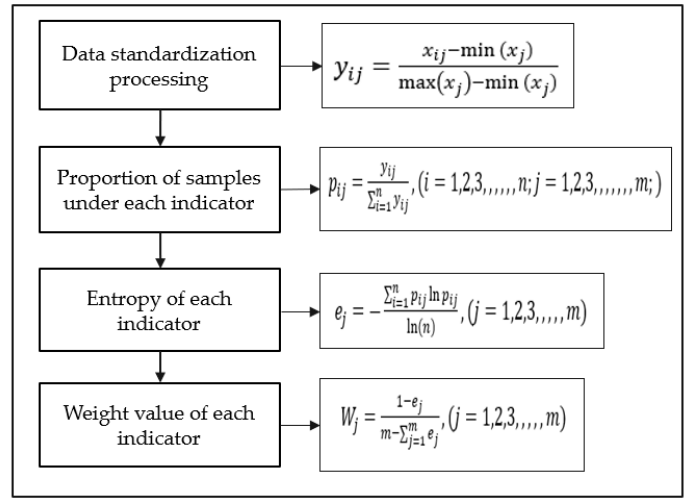
Figure 7. Flowchart of the entropy method.